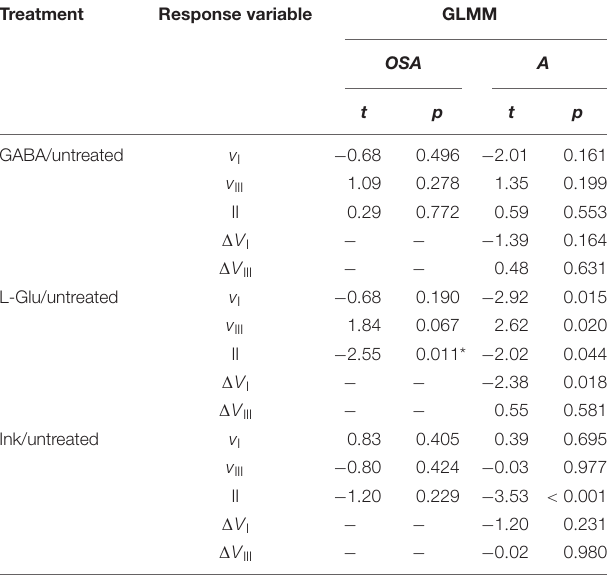
TABLE 4 | Generalized linear mixed-effect model (GLMM) coefficients ( t - and p -values) for changes in osculum cross-sectional area ( OSA ) and projected area ( A ) of Halichondria panicea explants under different treatments (GABA, L-Glu or ink) versus untreated conditions (fixed effect), taking into account variability in A (fixed effect) and individual variation ( ID #; random effect).